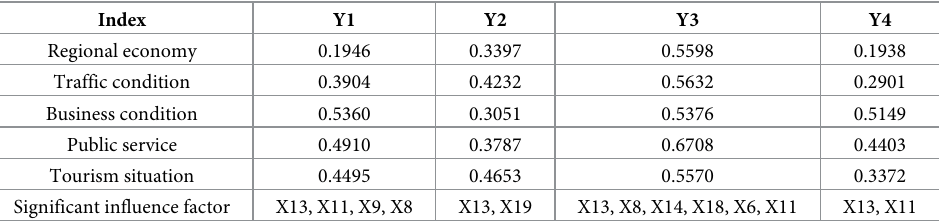
Table 4. The average value of hotel industry factors and the significant impact factors in